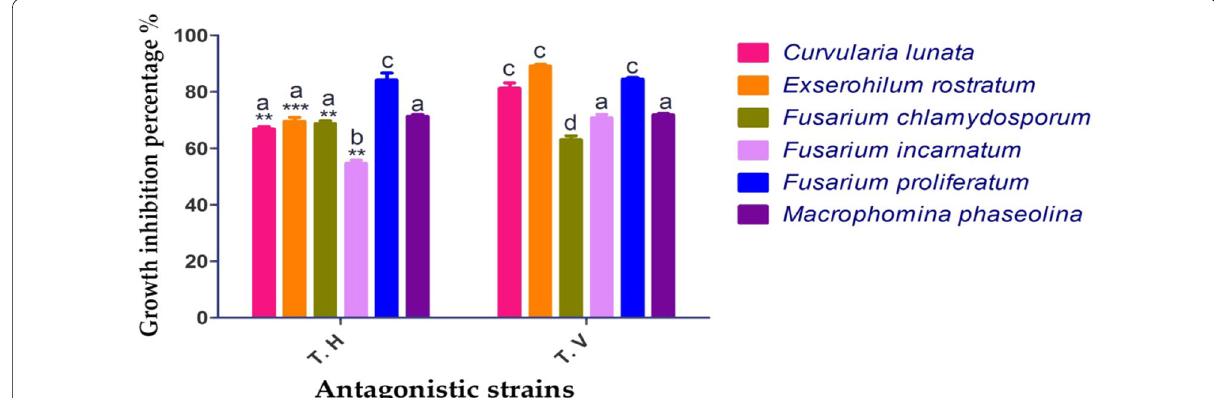
Fig. 2 Antagonistic activity of T. viride and T. harzianum against different fungal phytopathogens. *Asterisk s indicate that the antagonistic activity of T. harzianum against Curvularia lunata , Exserohilum rostratum , Fusarium chlamydosporum , and Fusarium incarnatum was significantly different